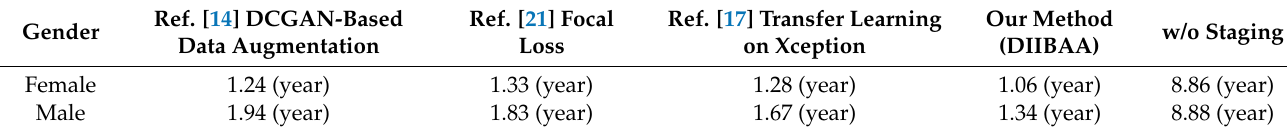
Table 10. MAE on three common methods for data imbalance